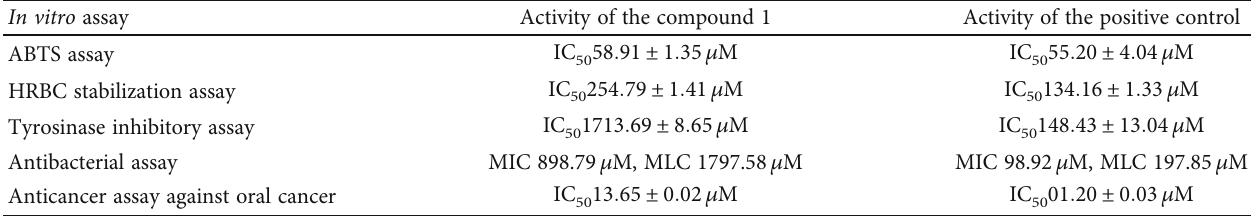
Table 3: In vitro assay activity comparison of the compound 1 with respective positive controls.